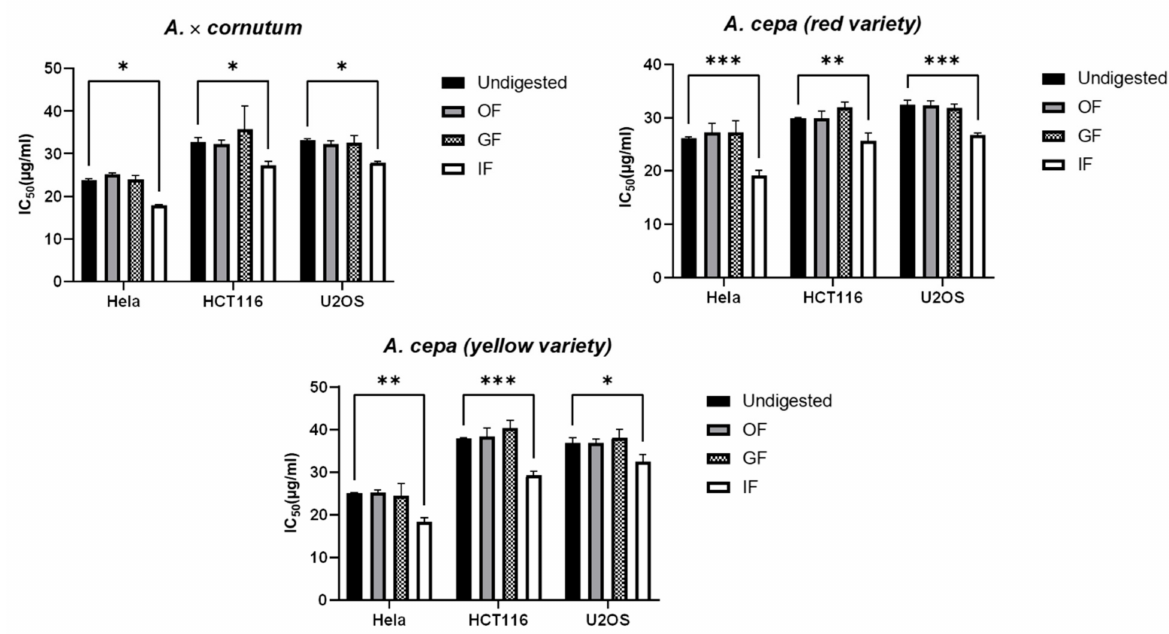
Figure 2. Antiproliferative activity of digested onion waste extracts determined by MTS-based cell proliferation assay. The results are expressed as mean values of three independent experiments ± SD (standard deviation). Statistically significant differences are marked with * p < 0.05, ** p < 0.01 and *** p < 0.001 (Data S5–S7). Undigested—control extract, OF—oral phase, GF—gastric phase and IF—intestinal